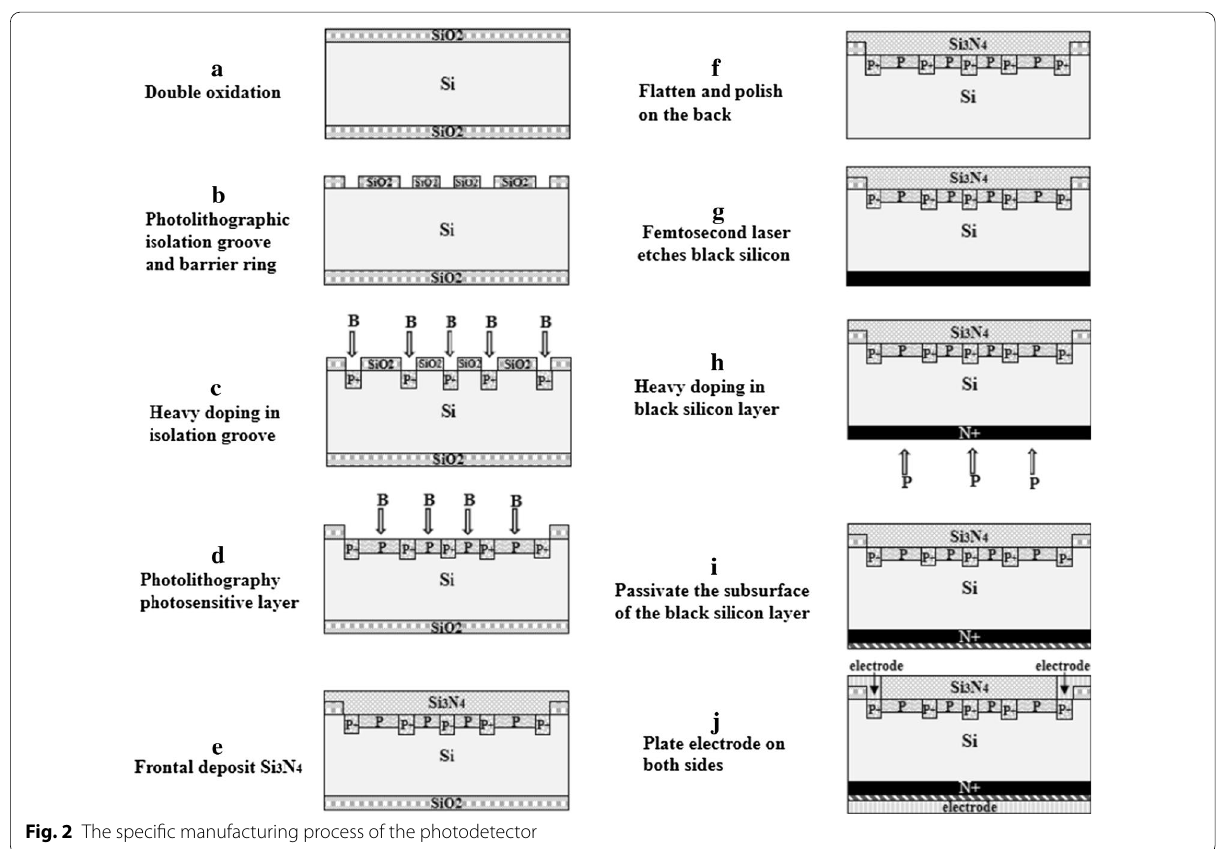
Fig. 2 The specific manufacturing process of the